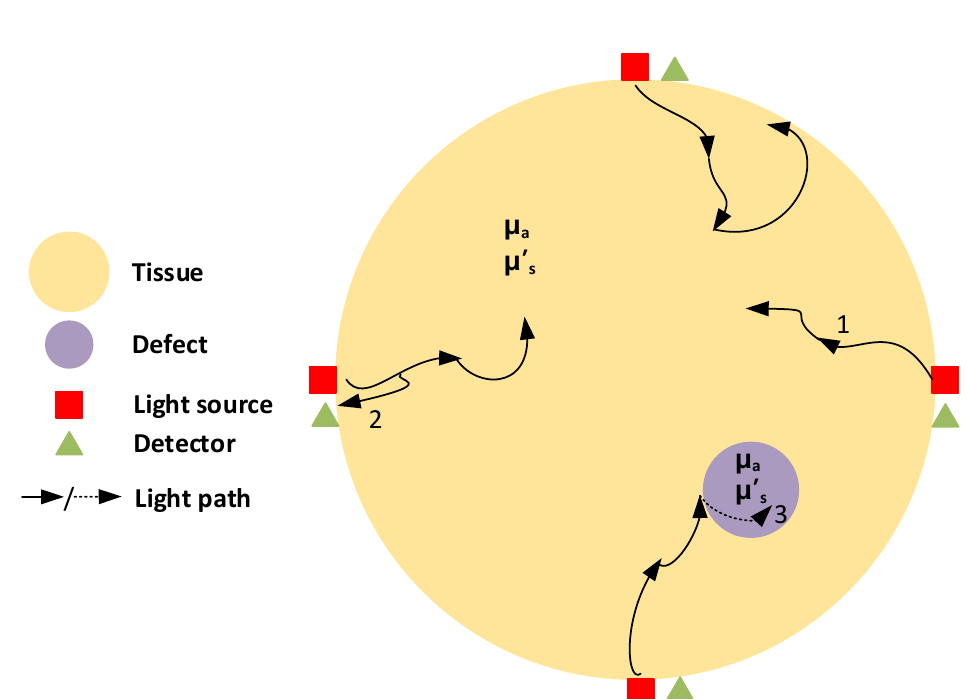
Figure 1. NIR-DOT measurement demonstration. The yellow circle is tissue, the magenta circle is a defect, the red rectangle is the light source, the green triangle is the detector, and the dark arrow is the light path. Additionally, 1 is the light penetrating inside the tissue, 2 is the light penetrating back to the detector, and 3 is the light penetrating through the defect.